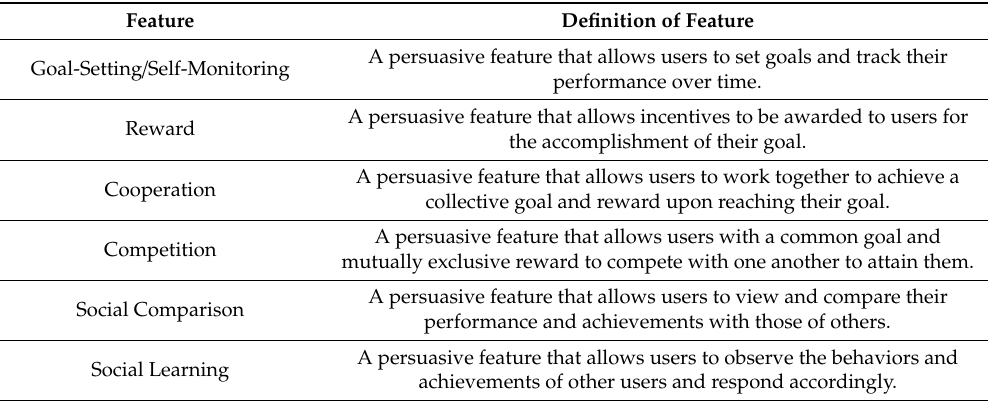
Table 1. Persuasive features and definition